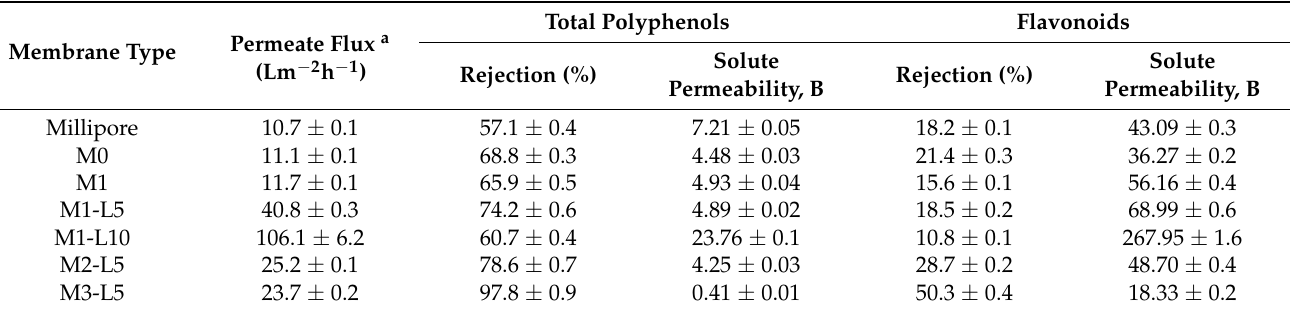
Table 2. Permeation performance and rejection for total polyphenols and flavonoids from apple pomace extract for the prepared